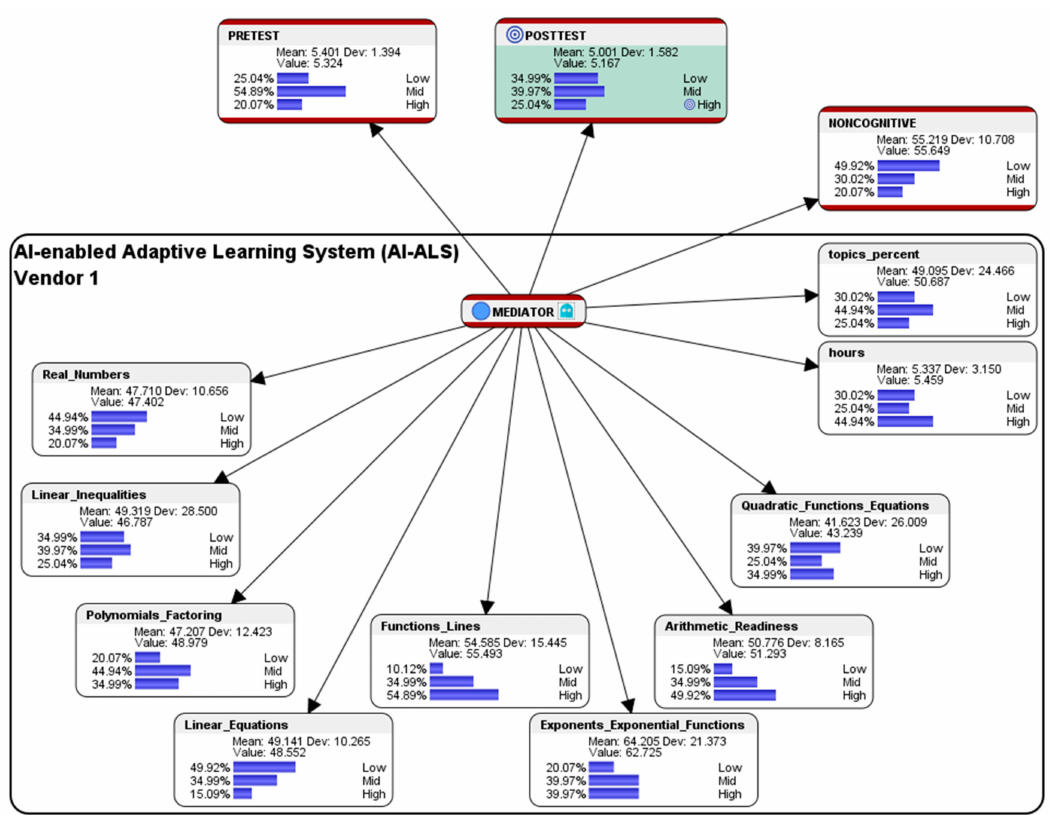
Figure 7. BN model of the students who had used the AI-ALS from Vendor 1 (N = 20